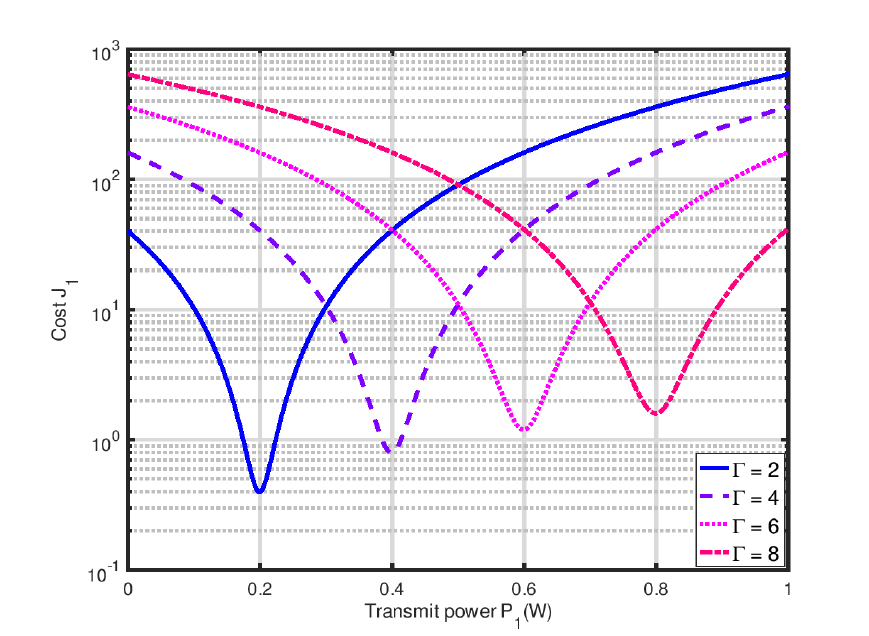
Figure 5. Nash equilibrium depends on the target